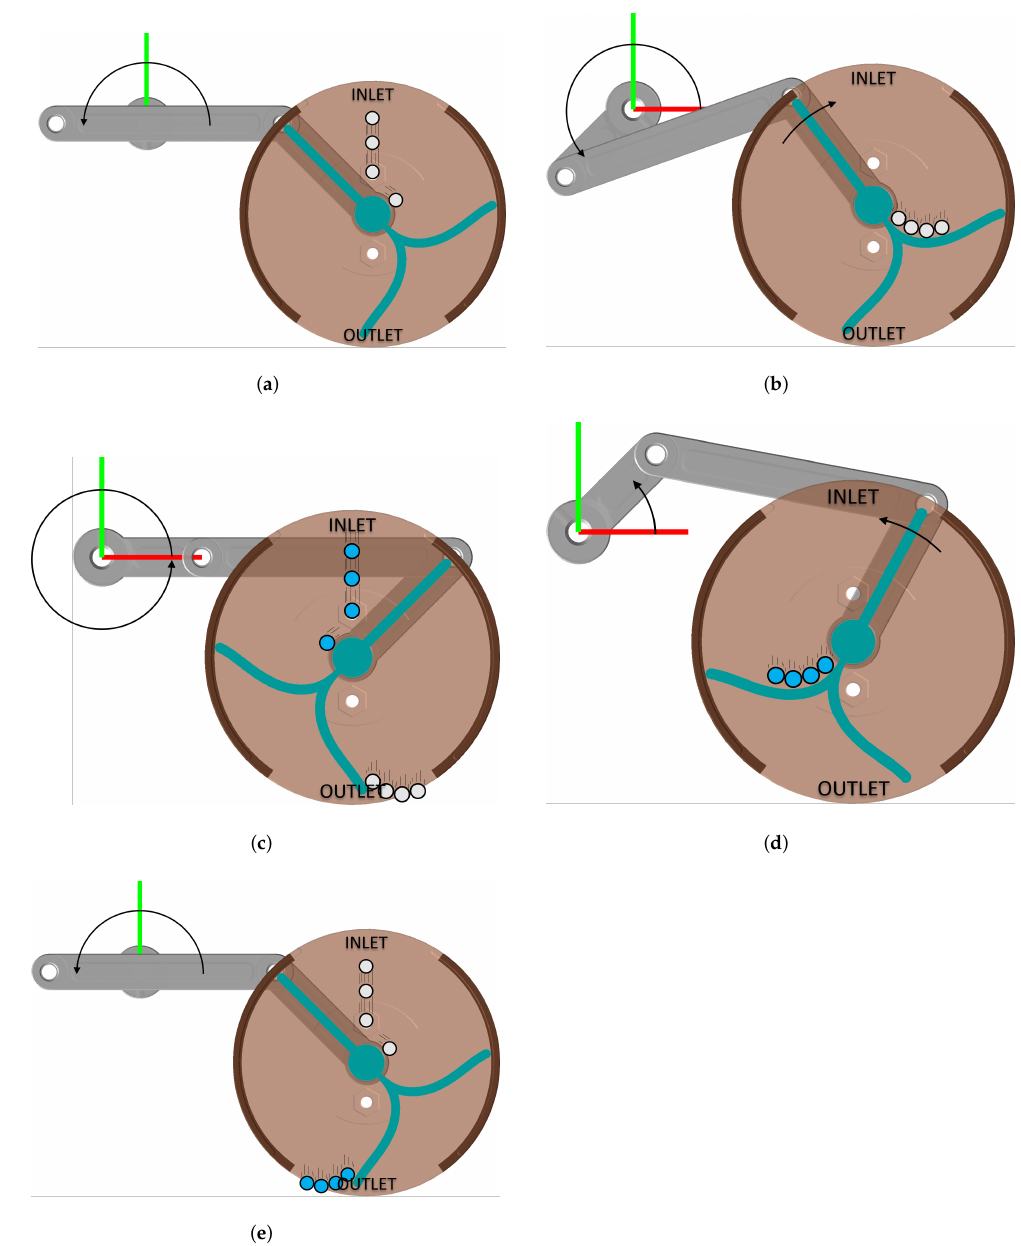
Figure 2. Functioning of the mechanism. The rotary distributor (teal green) moves to the left and to the right to batch components, while the four-bar linkage mechanism is driven by a motor fixed to the crank which rotates at constant speed. The parts fall into the compartment from the inlet (to the top) and exit from the outlet (to the bottom) under the action of gravity. In the sequence depicted above, the first set of parts (white) exits to the right ( a – c ), and the second set (blue) exits to the left ( c – e